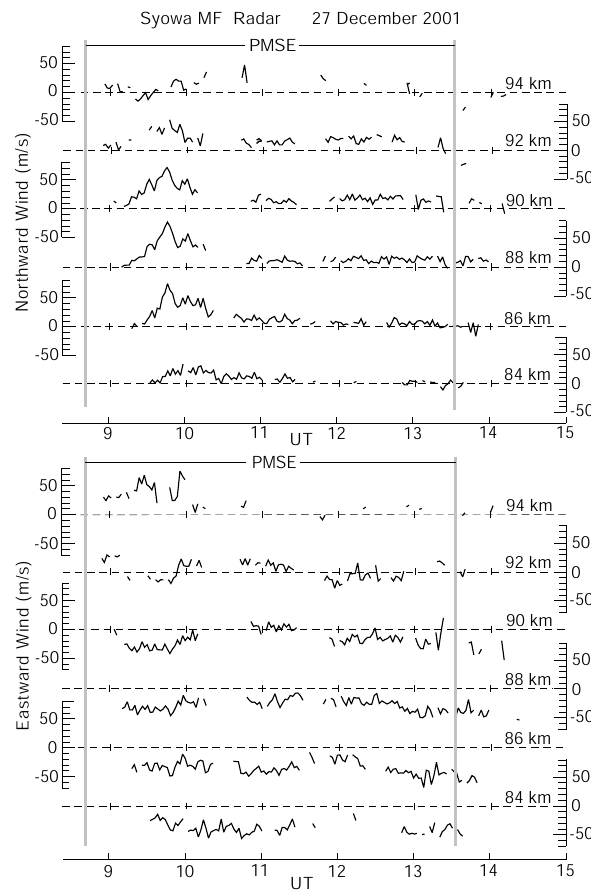
Fig. 9. Time and altitude variations of (upper) northward and (lower) eastward winds observed with the Syowa MF radar. PMSE occurrence period detected with the Syowa HF radar is